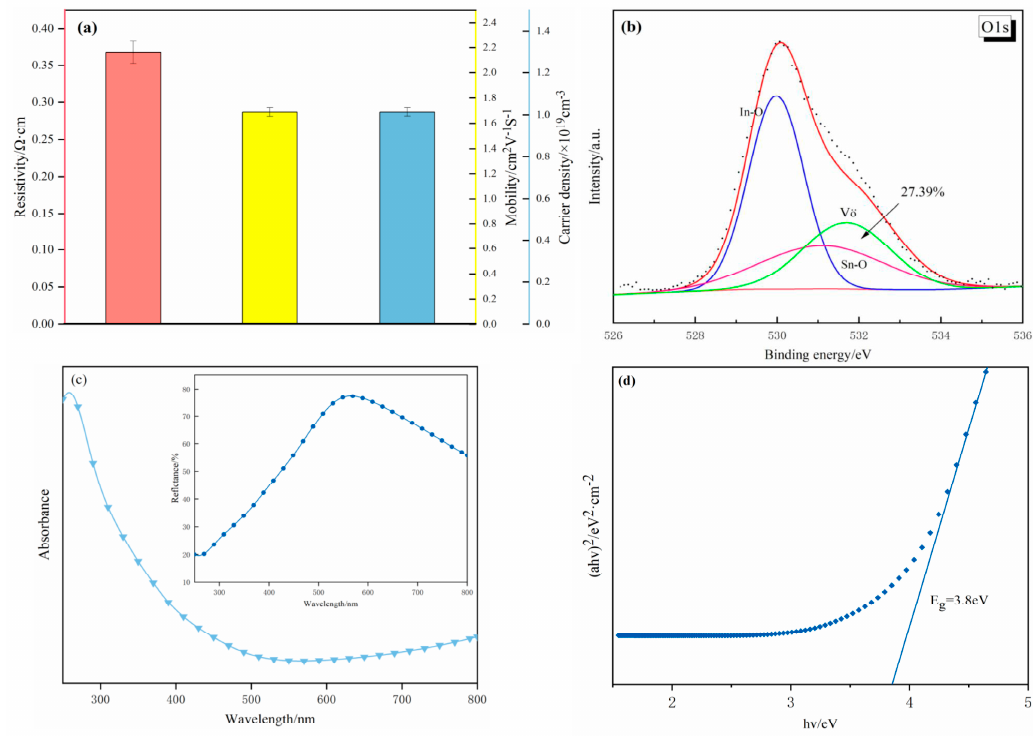
Figure 5. Electrical properties, XPS, diffusion reflection spectra of ITO nanoparticles: ( a ) electrical properties; ( b ) eeconvolution O 1s XPS spectra; ( c ) UV-Vis absorption spectra (insert of diffusion reflection); ( d ) plot of ( α hv ) 2 as function of hv .